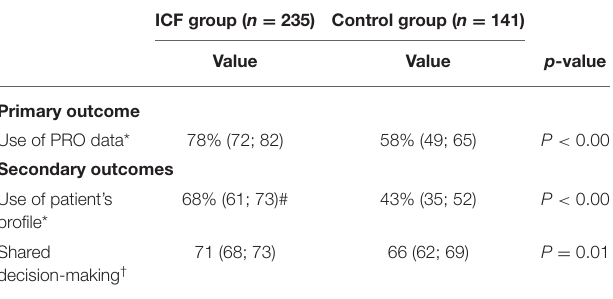
TABLE 5 | Comparison; use of PRO data, patient’s profile and shared